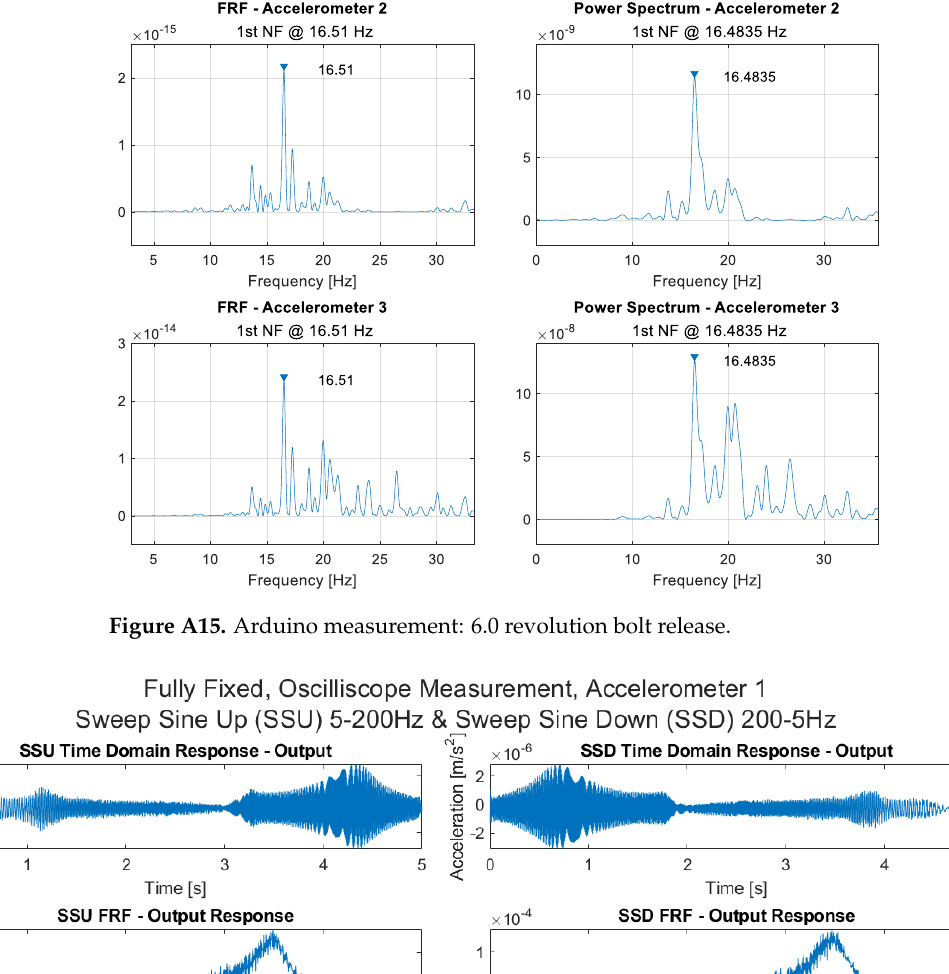
Figure A14. Arduino measurement: 5.0 revolution bolt release.